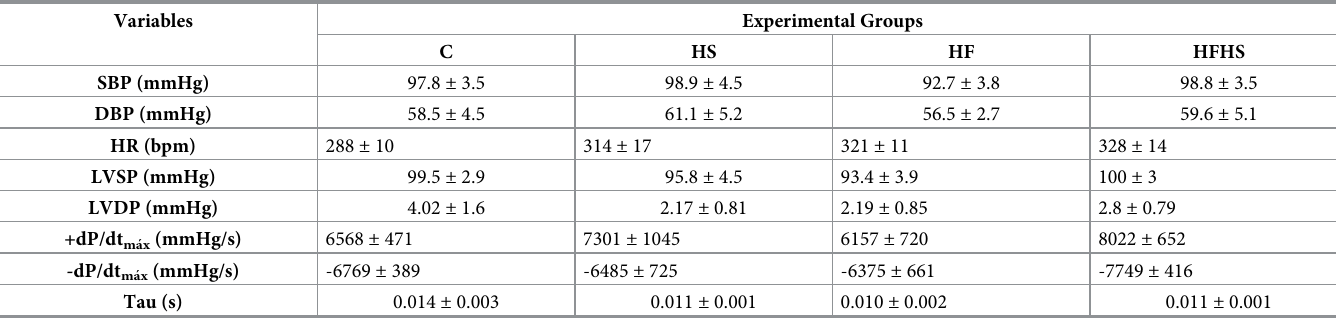
Table 3. Left ventricular hemodynamics measurements.